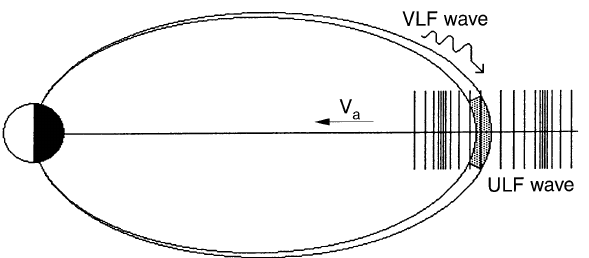
Fig. 1. Geometry of the problem. The VLF wave propagating in the thin flux tube is amplified in the small region ( shaded ) near the equatorial plane. The magnetic field B (cid:122) inside the flux tube is believed to pulse as sin (cid:88) t , where (cid:88) is the perturbation